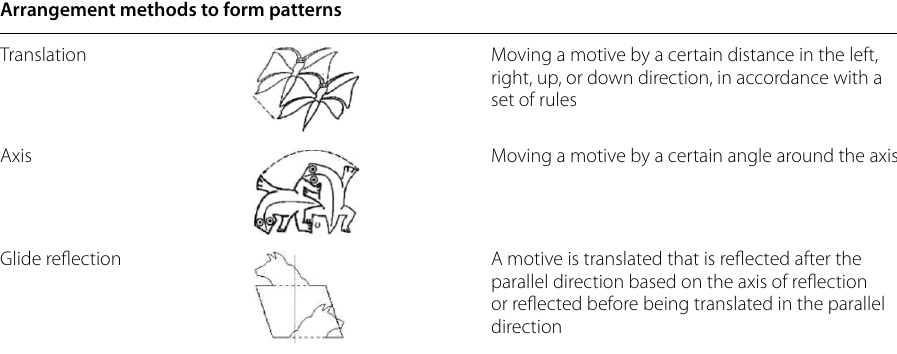
Table 3 Arrangement methods to patterns Arrangement methods to form patterns